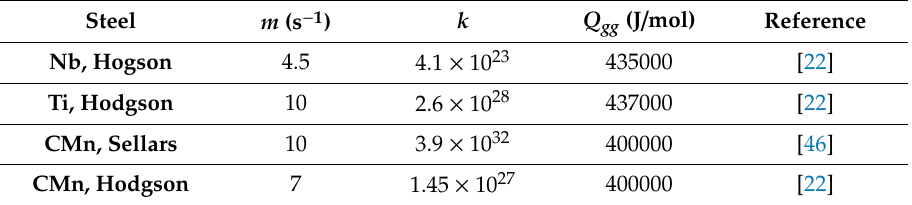
Table 7. Values of the parameters proposed for some grain growth models in the